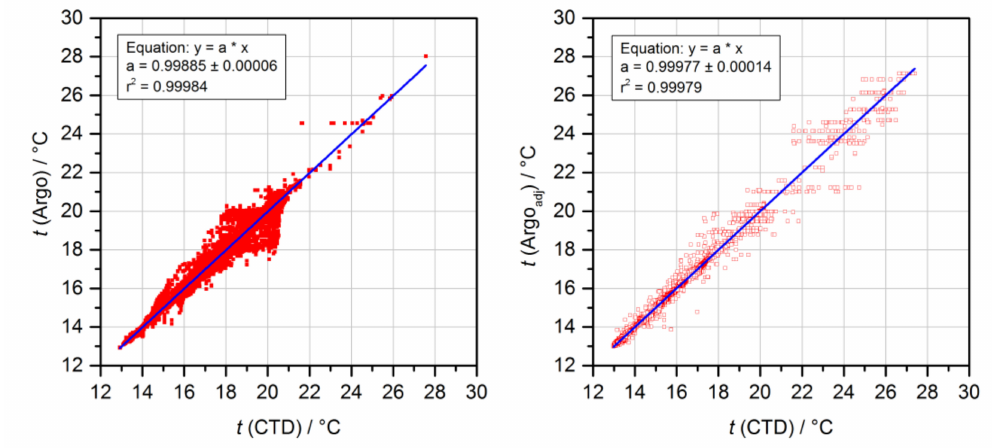
Figure 18. Scatter diagram and linear regression (slope a , coe ffi cient of determination r 2 ) of Argo (not-adjusted, left , and adjusted, right ) vs. CTD values: temperature (all data in the water column).